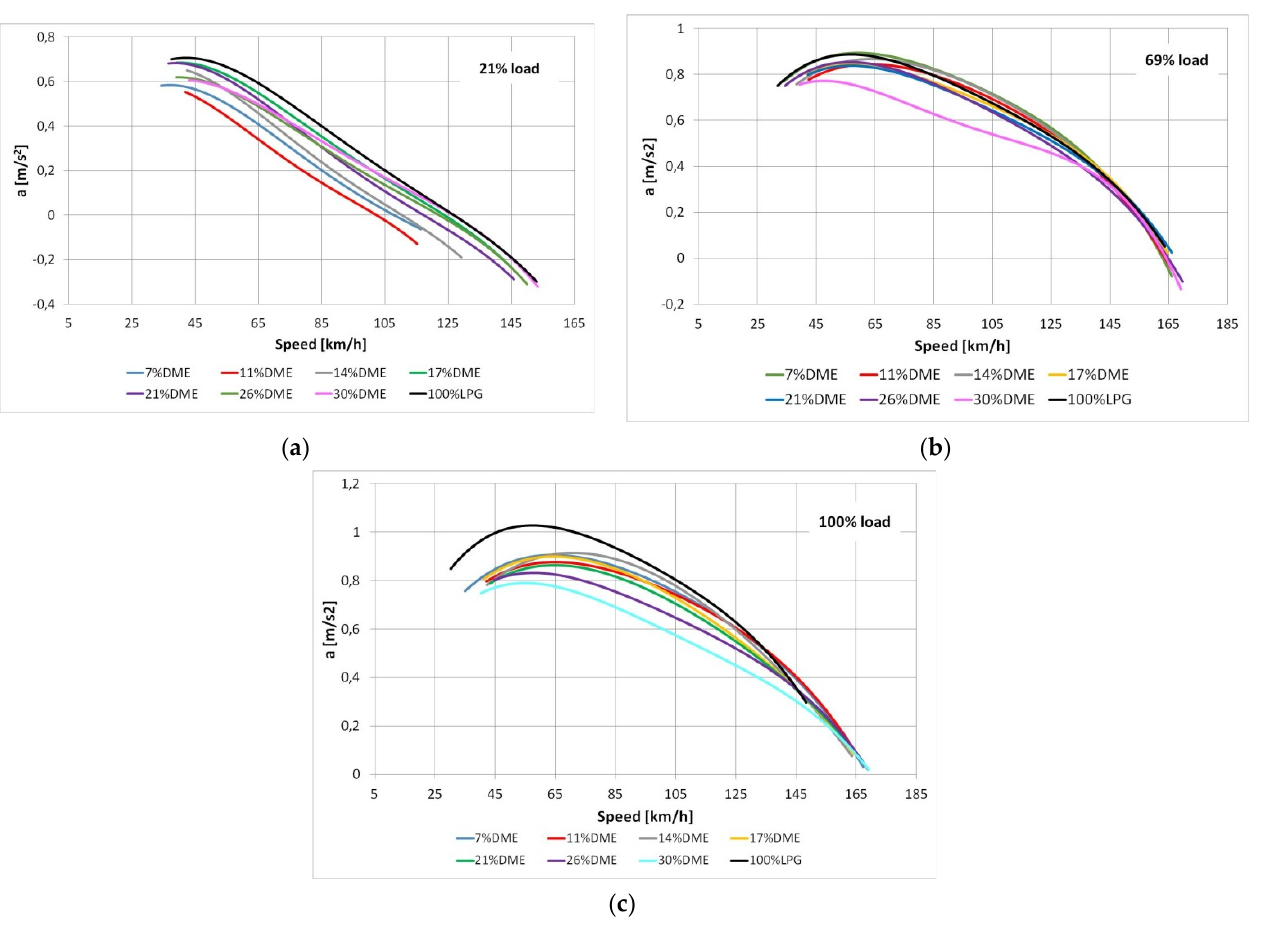
Figure 10. Vehicle acceleration for the first gear, different mass fraction of DME and ( a ) 21% load, ( b ) 69% load, ( c ) 100% load.